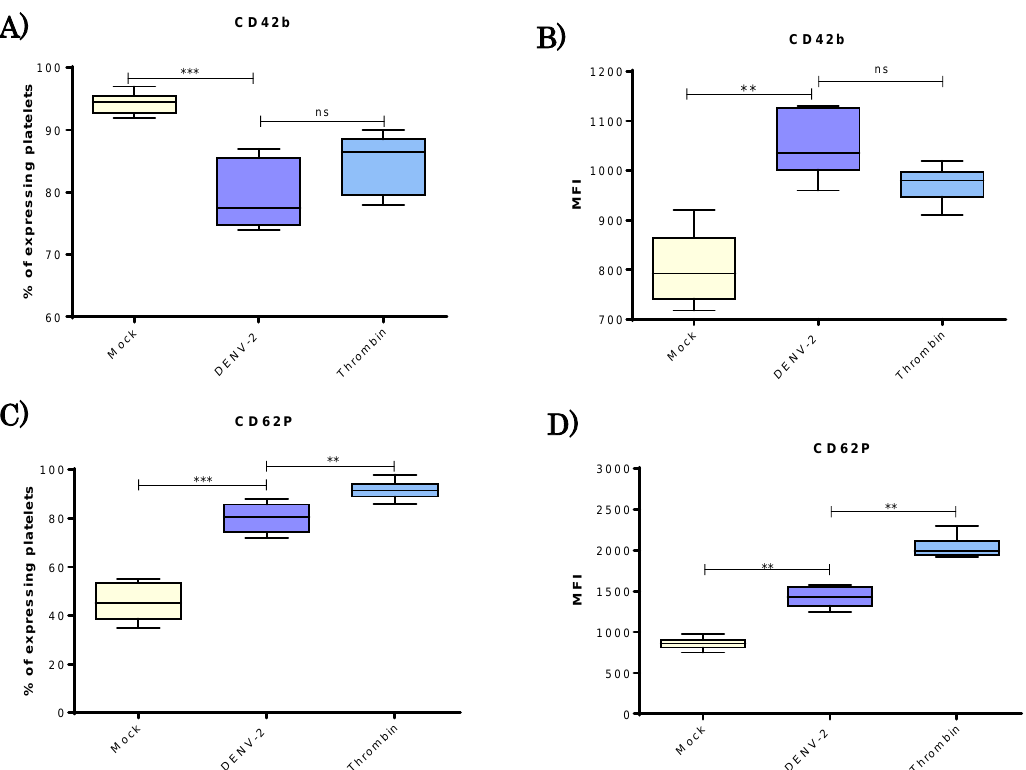
Figure 2. DENV-2 induced changes in CD42b molecule and activation CD62P marker on human platelets. Platelets from healthy donors ( n = 10) were analyzed. Platelets were incubated with DENV2 to a MOI of 0.5 for 4 h at 37 ◦ C. For each experiment, mock and thrombin groups were included. Percentages of platelets expressing CD42b molecule in each group are shown ( A ); as well as median fluorescence intensity (MFI) that indicate density of of CD42b molecule on the cell surface ( B ); as a measure of platelet activation, the percentage of CD62P-expressing platelets was determined ( C ); as well as MFI of CD62P expression ( D ). Unpaired t -test and Mann-Whitney U distribution were used for these experiments, where ** p < 0.01 and *** p < 0.001, ns = not